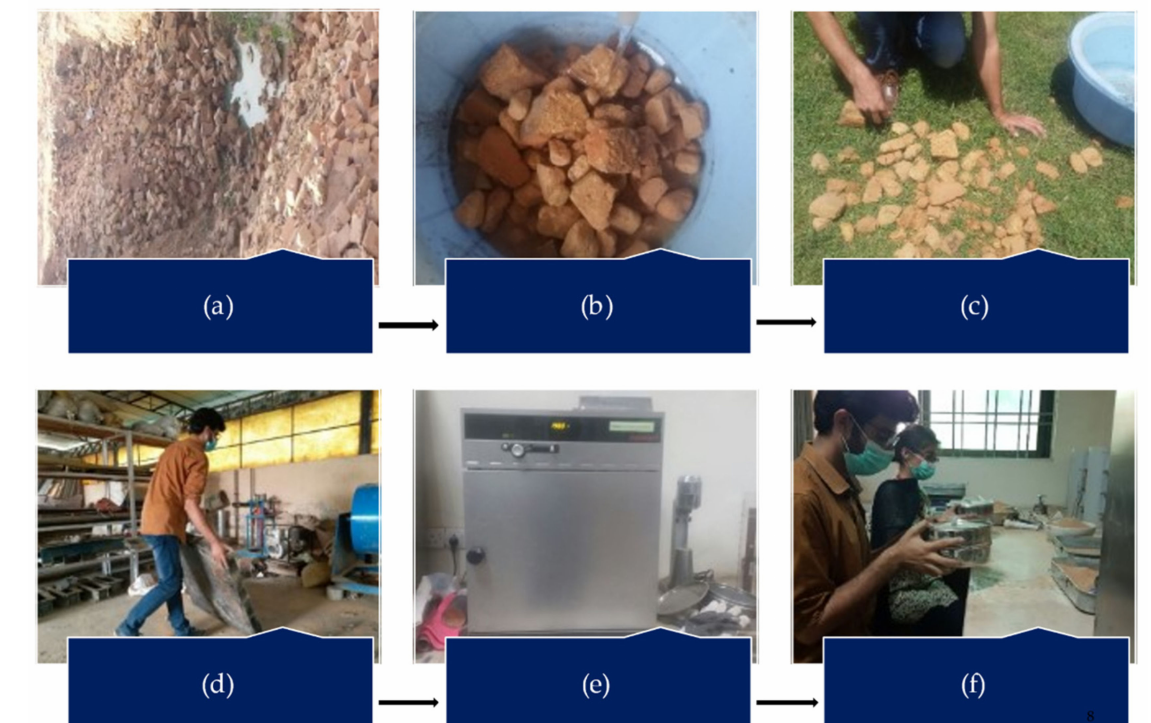
Figure 3. Preparation process of waste burnt brick powder (WBBP): ( a ) collection site of waste bricks; ( b ) collected bricks are crushed into smaller size and washed to remove dirt; ( c ) the wet pieces of waste bricks are dried under sunlight for 1 day; ( d ) The sun-dried sample is converted into powder using the ball milling process; ( e ) to remove any moisture content, the WBBP is oven-dried for 24 h; ( f ) the oven-dried powder is converted into ultrafine particles through manual pulverization, and then it is sieved through a 75 µ m sieve and stored in airtight buckets.